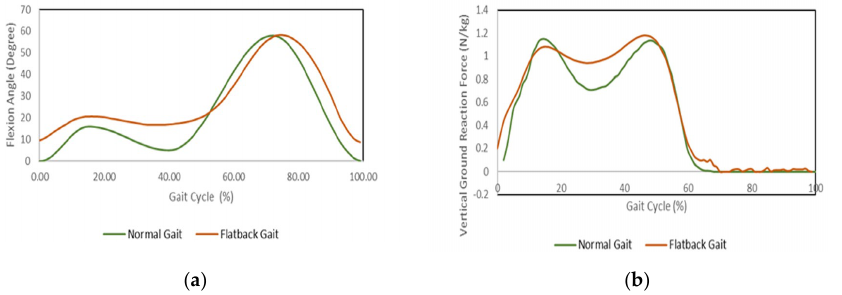
Figure 6. The difference between the normal gait mechanism and the flatback gait mechanism: ( a ) flexion angle; ( b ) vertical ground reaction force.